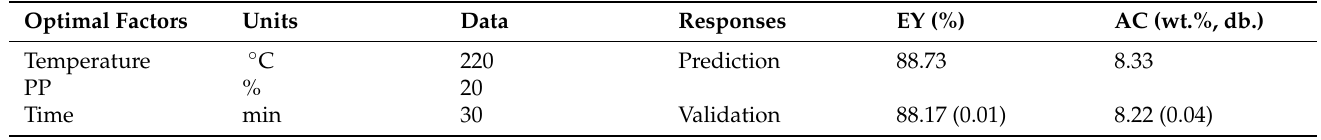
Table 5. Validation results for the optimized set of responses of